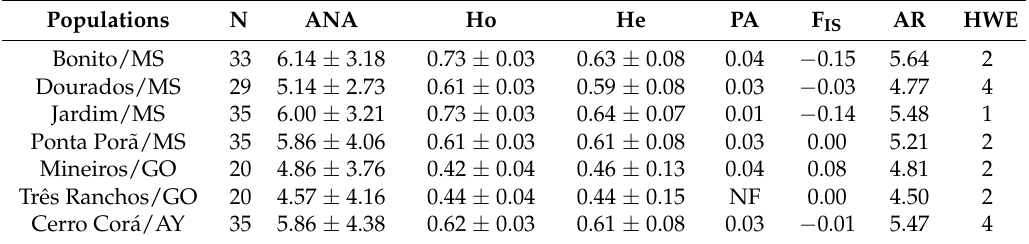
Table 2. Genetic diversity of populations of Campomanesia adamantium .